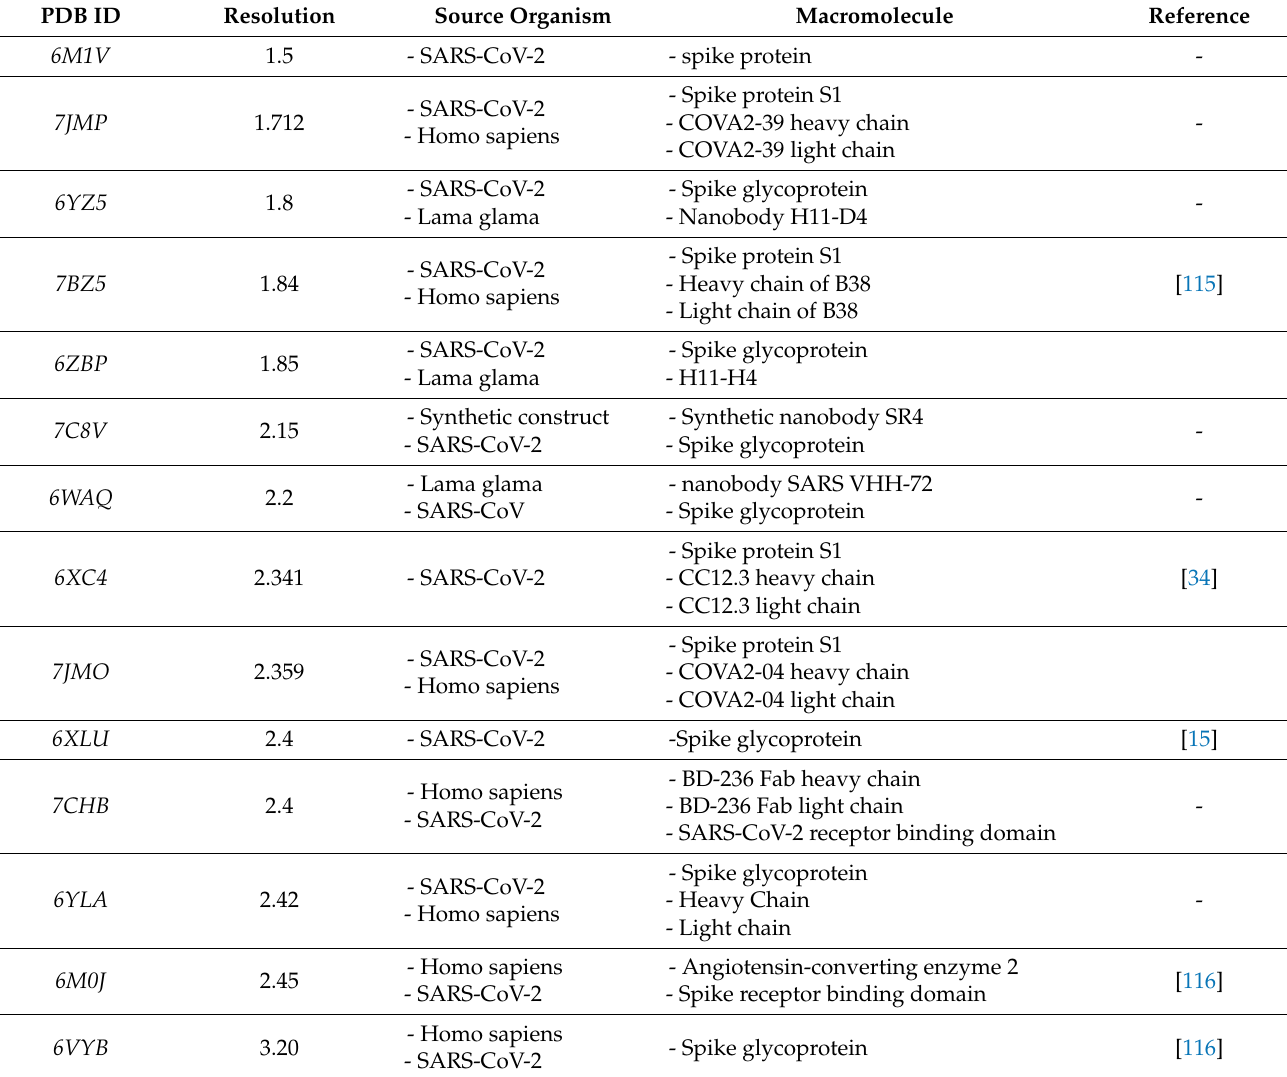
Table 3. The known 3D structures of Spike glycoprotein available on protein data bank (PDB). PDB